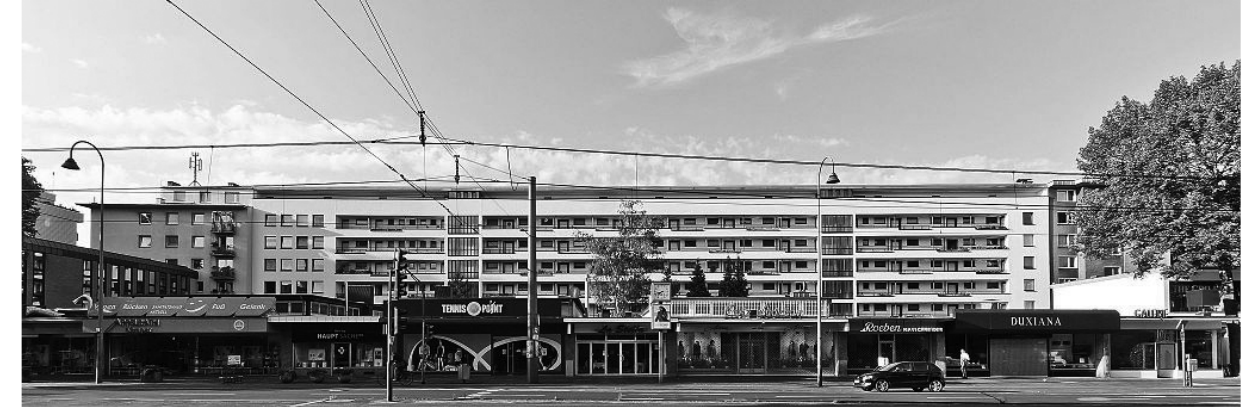
Figure 19. W. Riphahn, Hahnenstrasse complex (1945–1952). Source: Spekking